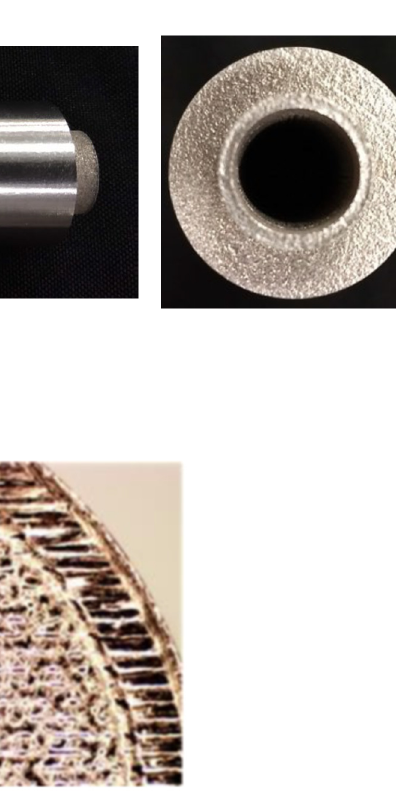
Figure 7. Microscopic view of AM sample featuring a porous structure surrounded by a solid wall [36].